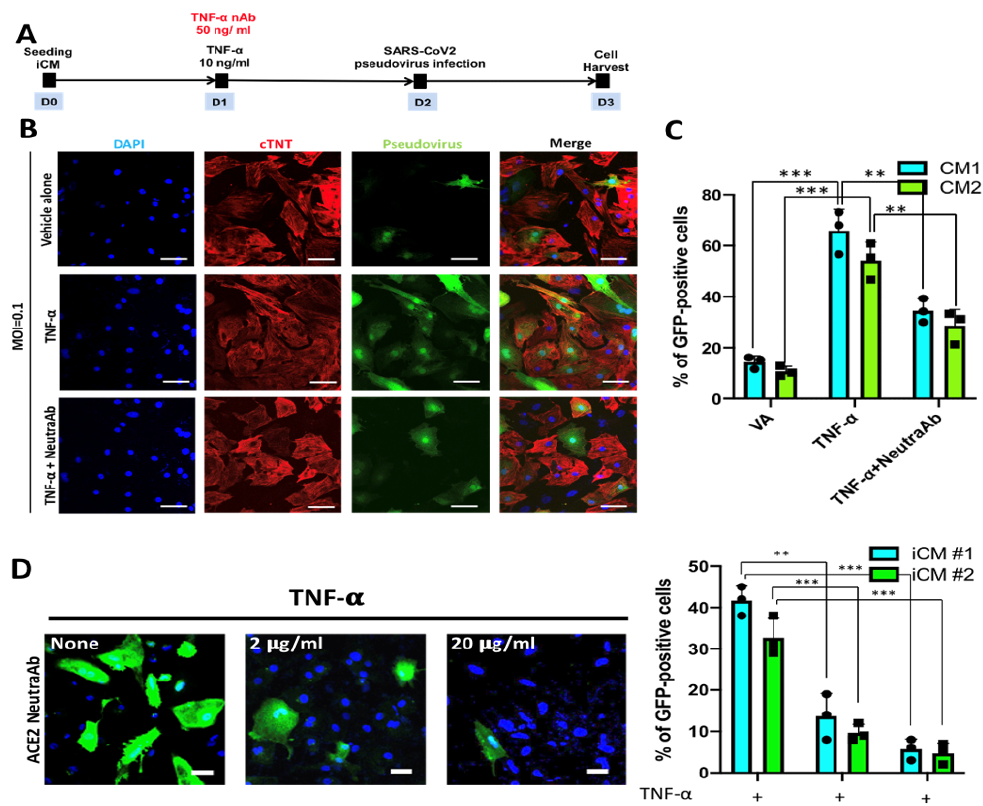
( D ) Quantifications of Western blots. ( E ) Upper panel: 24 h after seeding, iCMs were treated with TNF- α (10 ng/mL) for 24 h. After the TNF- α treatment, iCMs were infected with SARS-CoV2 pseudovirus. One day after the viral infection, iCMs were harvested and subjected to immunofluorescence staining. Lower panel: Immunofluorescence staining showed that the entry of SARS-CoV2 pseudovirus into iCMs was increased upon TNF- α treatment as compared with the treatment of the vehicle alone (VA). Scale bar = 50 μ m. ( F) Quantification of the immunofluorescence results. *** p < 0.001 vs. vehicle alone.